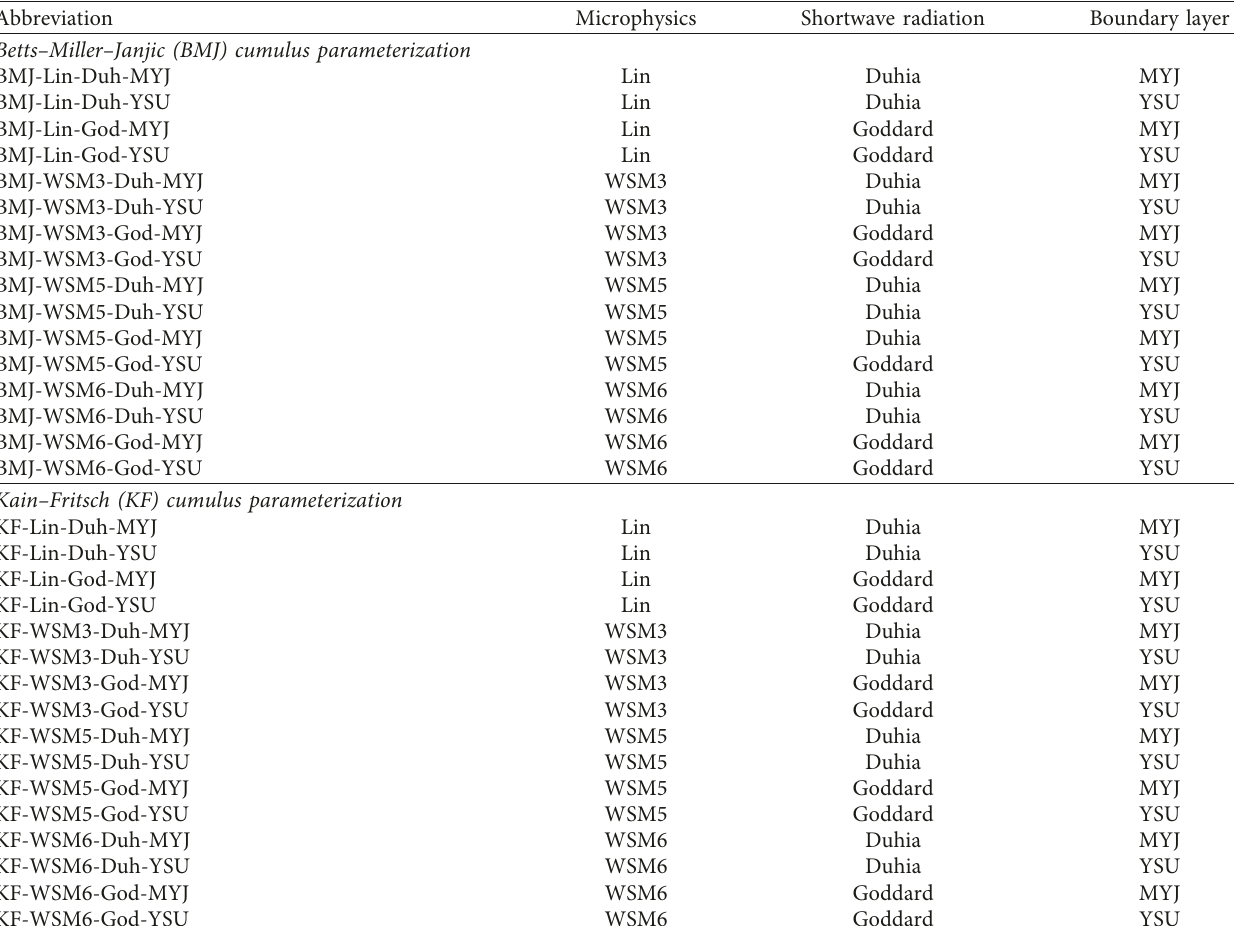
Table 2: Details of physical parameterization configurations in different